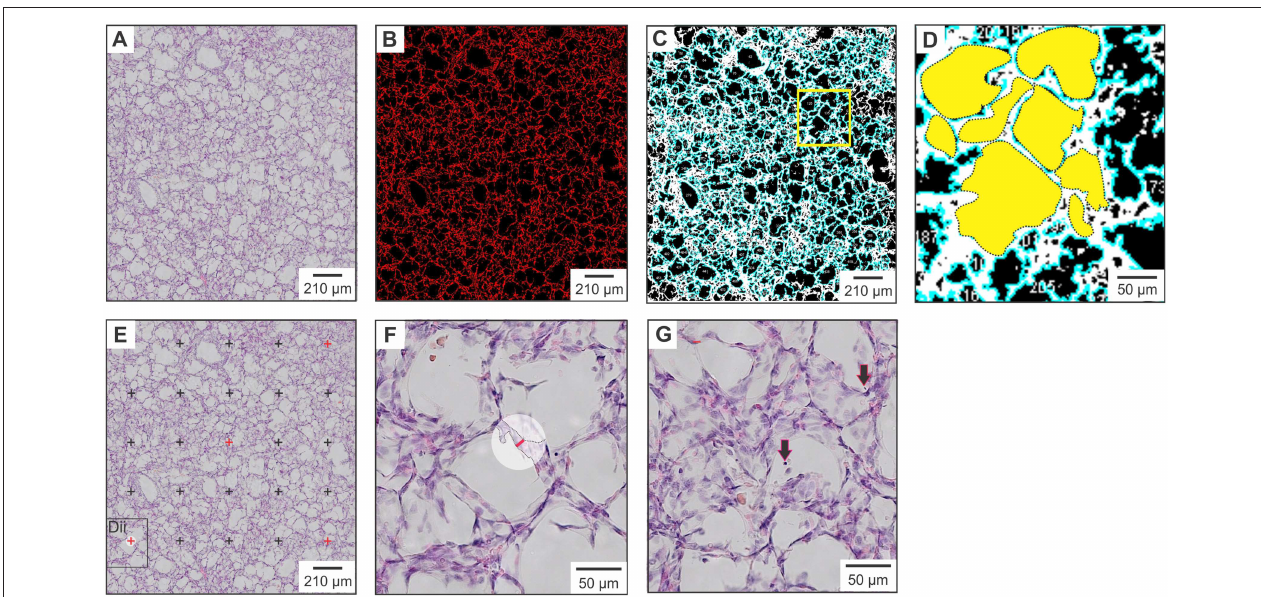
FIGURE 1 | Histological measures of lung injury. (A) Raw image cropped to size prior to processing and analysis with Image J. (B) Assessment of % lung tissue with measured areas of lung tissue highlighted in red. (C) Alveolar surface area measurements with alveolar units highlighted in blue. (D) Magnification of yellow square in panel (C) . Dotted outlines outline each alveolar unit, the area of which is shown in solid yellow. (E) Septal width measured at the five cross-points denoted in red. (F) Magnification of the black square in panel (E) , showing a septal width measurement (red line) made at the previously indicated cross-point. (G) Magnified image in which detached epithelial cells located within the alveoli are indicated by black